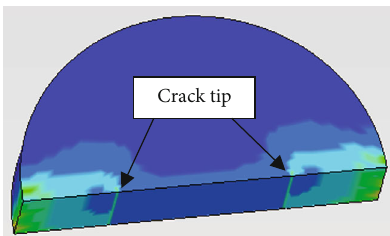
Figure 20: Three-dimensional distribution of stress in the CSTBD